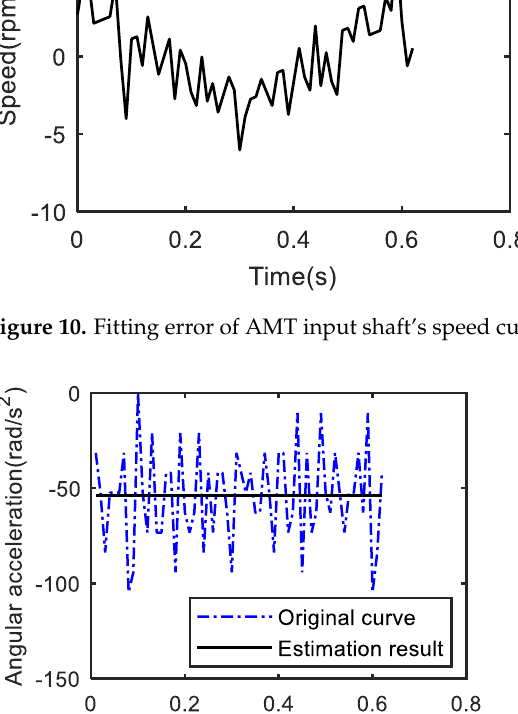
Figure 10. Fitting error of AMT input shaft’s speed curve without TB action.